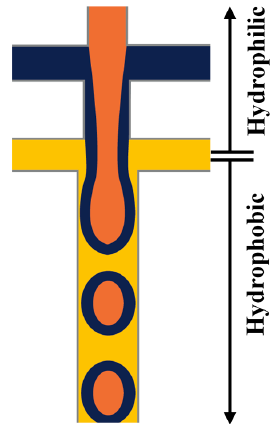
Figure 9. Producing O/W/O double emulsion in one step using two serial cross junctions. The first dripping instability was removed by increasing the fluid flow rates at the first junction [109].